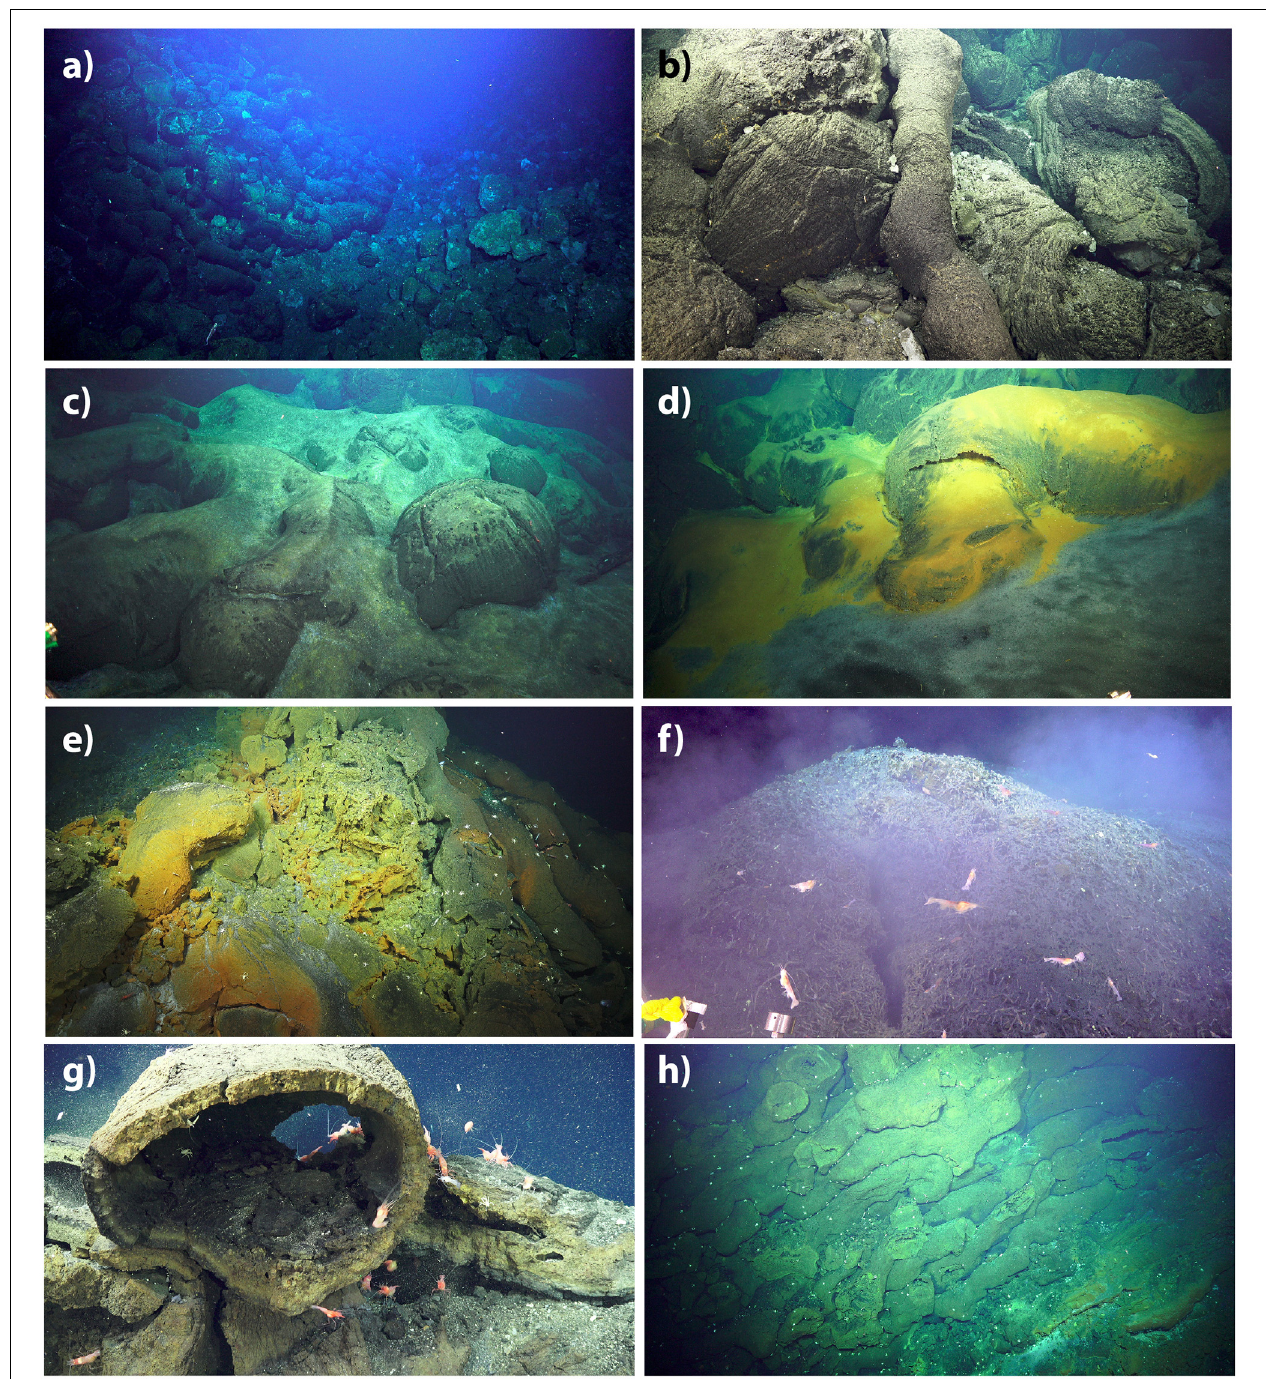
FIGURE 9 | Images of eruption site #2 from ROV SuBastian dives S85, S87, and S103. All show 2012–2016 eruption products. Numbers in parentheses are dive number, time of photo in GMT and horizontal scale. See Figure 8d for photo locations. (a) 2012–2016 flow front at left against the 2010–2011 landslide headwall at right (S85, 01:52:19, 10 m). (b) Close up of pillow lavas on flow front (S85, 01:58:13, 3 m). (c) Tephra partly burying pillows close to eruptive vent (S85, 02:59:14, 5 m). (d) Tephra with white and yellow microbial mats mantling pillows (S85, 03:18:12, 3 m). (e) Near-vent spatter deposits with yellow hydrothermal sediment (S85, 02:50:48, 5 m). (f) Hydrothermal vent shrimp swarm at active diffuse vent with shimmering cloudy water (S87, 03:19:25, 3 m). (g) Hollow drained-out pillow where new lavas are cut by landslide scarp (S103, 02:42:53, 1.5 m). (h) Cross-section of stack of elongate pillow lavas cut by landslide scarp, with downslope direction to the left (S85, 02:45:15, 10